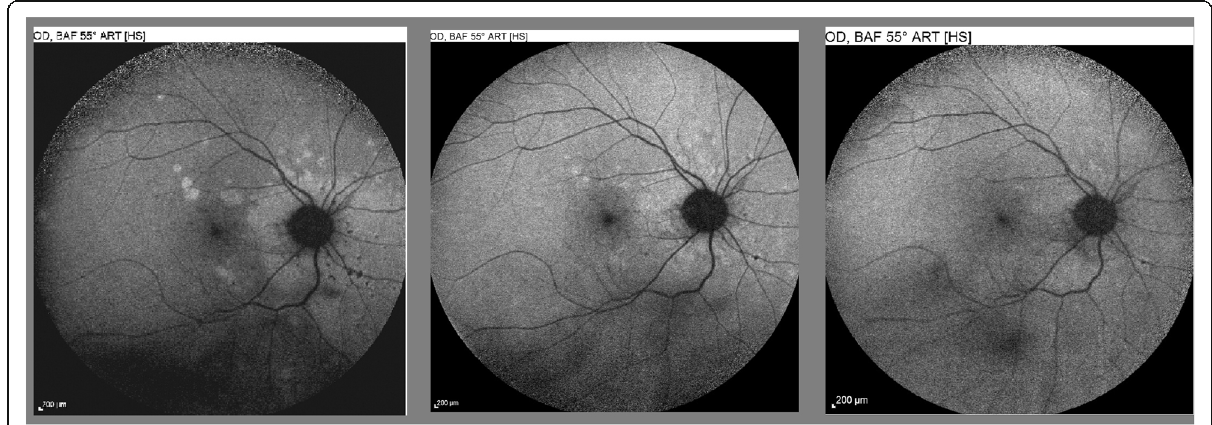
Fig. 9 Multifocal choroiditis (MFC), BL-FAF. Hyperautofluorescence around optic disc at presentation (left picture) that decreases after introduction of corticosteroid/immunosuppressive therapy (middle picture) and disappears at the end of therapy (right